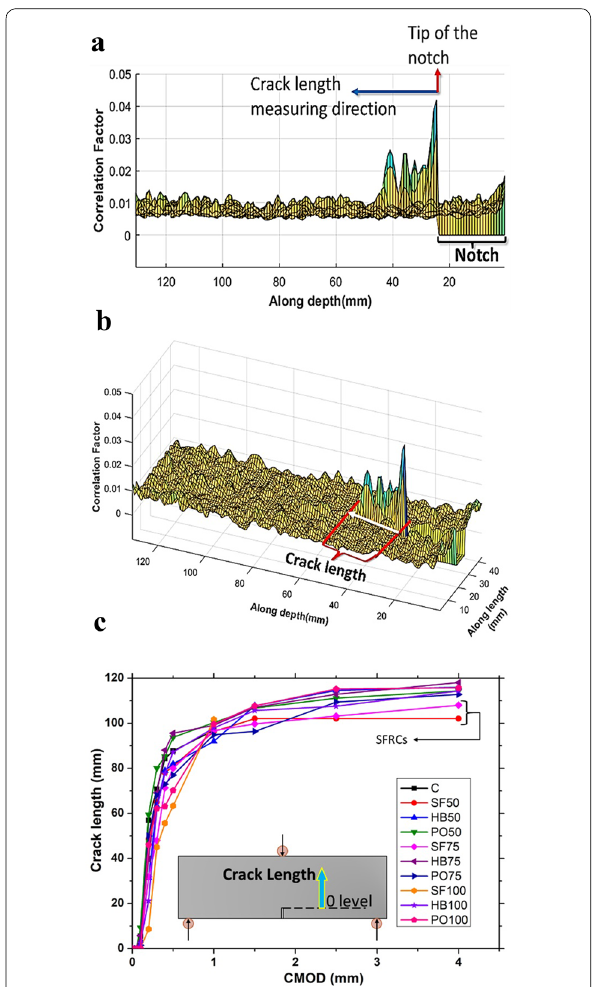
Fig. 14 Illustration of measurement of crack length from the notch tip and graphs of crack length Vs. CMOD: a variation of correlation factor along the depth of the specimen HB100 at 0.2 mm CMOD; b measurement of crack propagation from the notch; c crack length vs. CMOD graphs of all